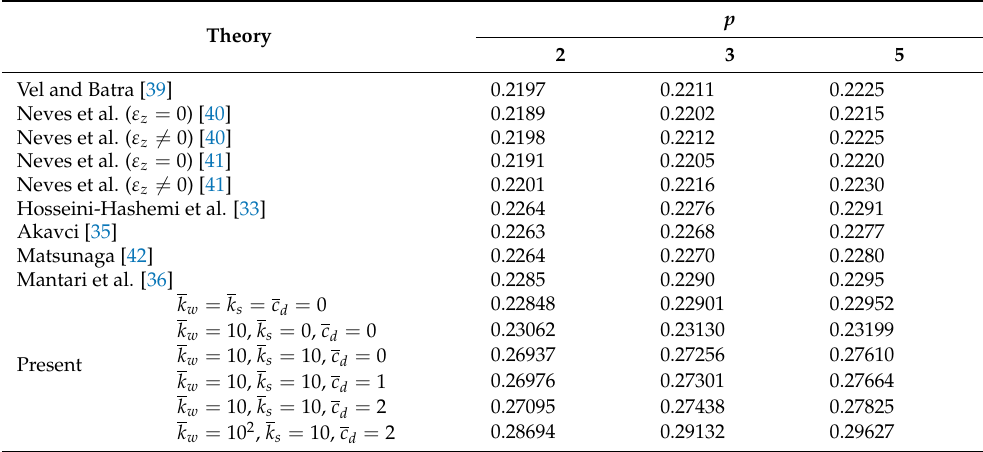
Table 5. Non-dimensional fundamental frequencies ˆ ω = ω h resting on Visco-Winkler-Pasternak foundations ( a / h = 5).